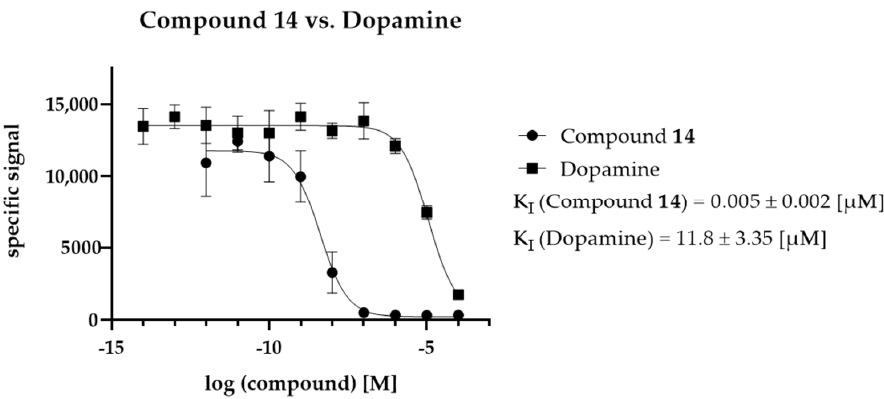
Figure 8. Comparison of the K I values of dopamine (endogenous ligand) and compound 14 (highest activity of the identified ligands). K I values were determined with n = 6.